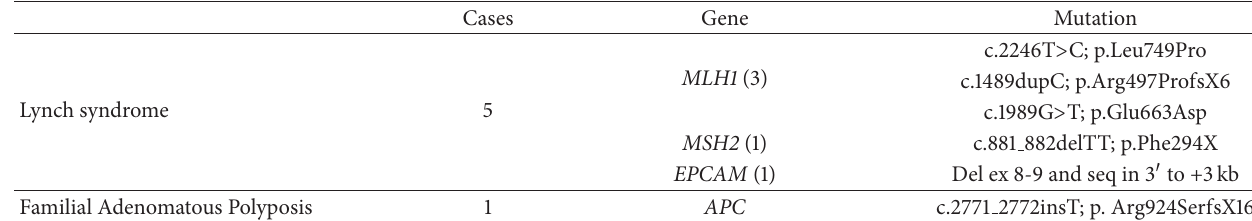
Table 3: Constitutional mutations in early onset colorectal